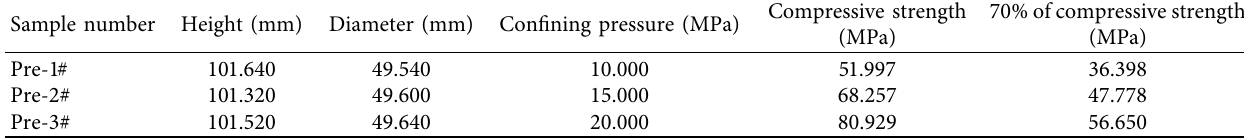
Table 1: Preliminary test results.